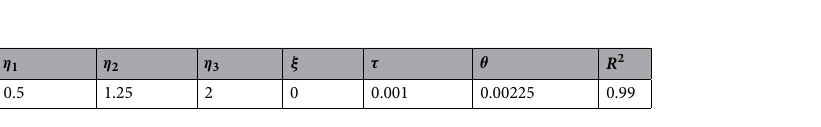
Table 3. Regression coefficients as obtained by the NMML